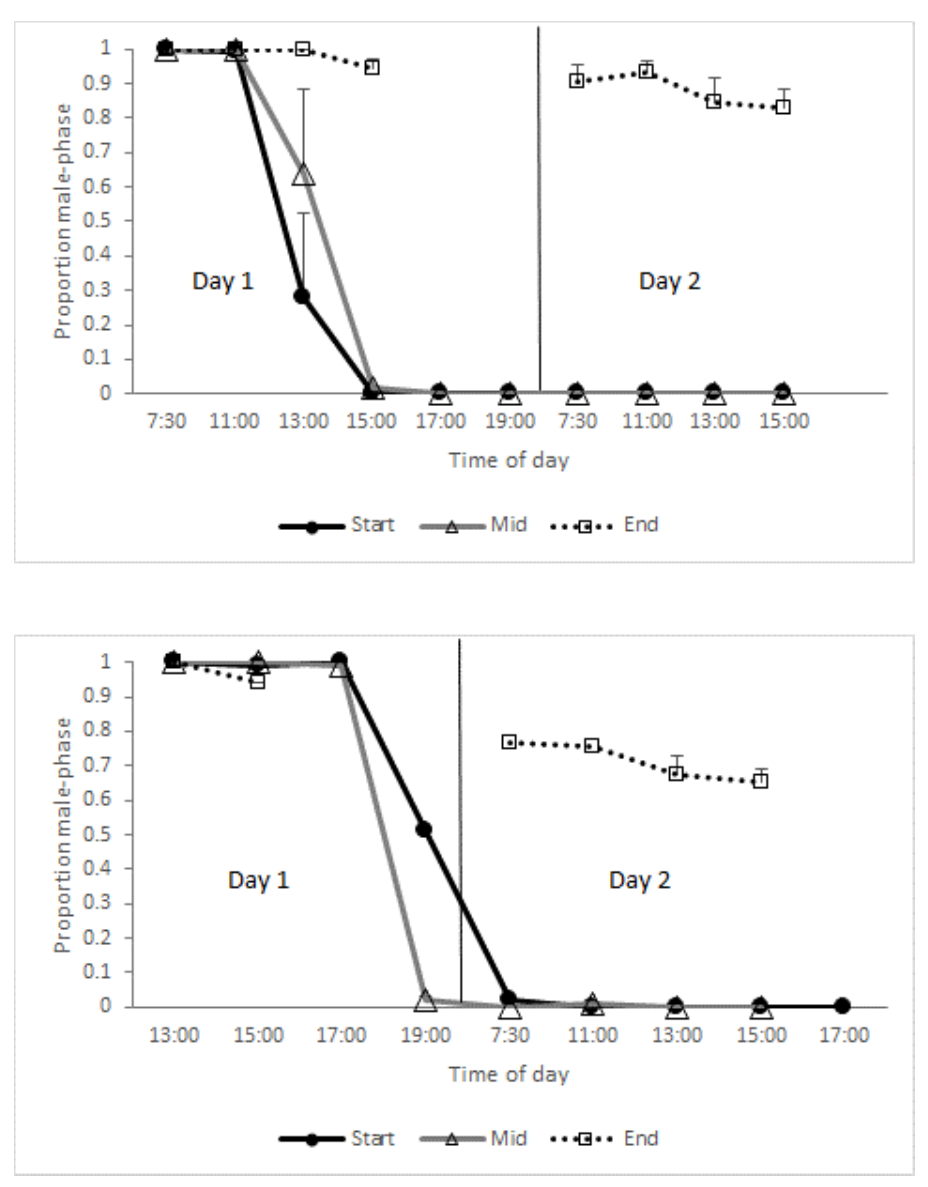
Figure 5. Mean per-tree proportions of male-phase flowers in the ‘Early’ (top) and ‘Late’ (bottom) flowering morphs along two consecutive days. Three trees of each flowering morph were monitored, at the start, middle, and end of the flowering season. Error bars are 1 SE .